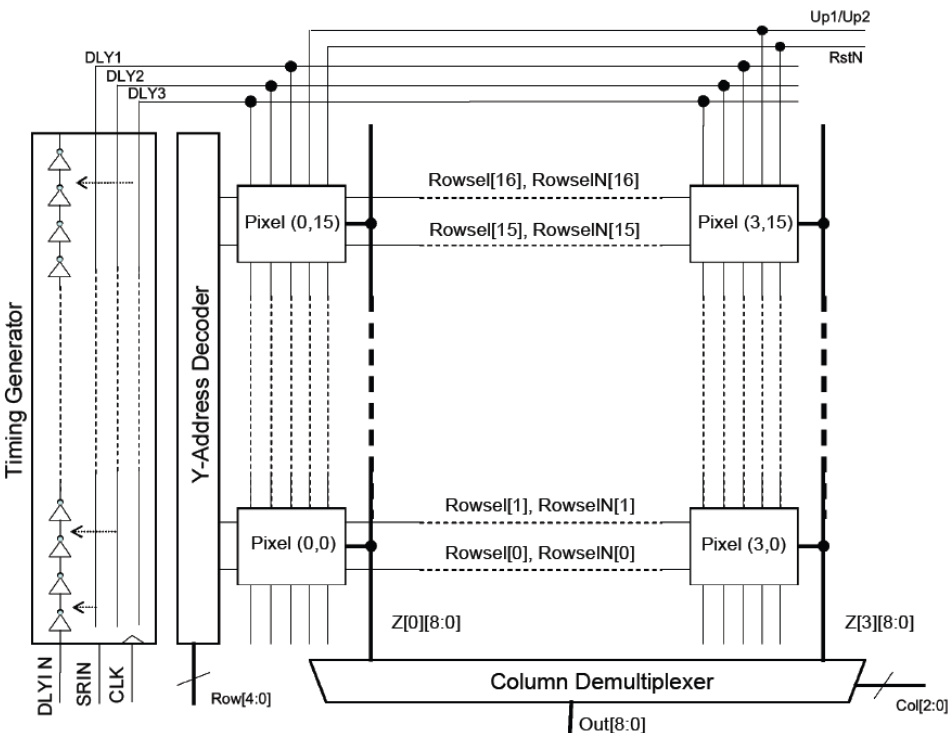
Figure 8. System block